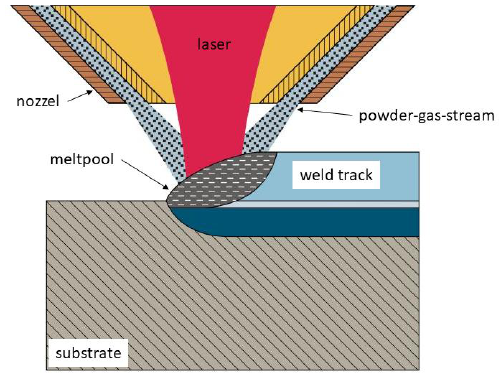
Figure 1. Schematics of the LMD process [18].